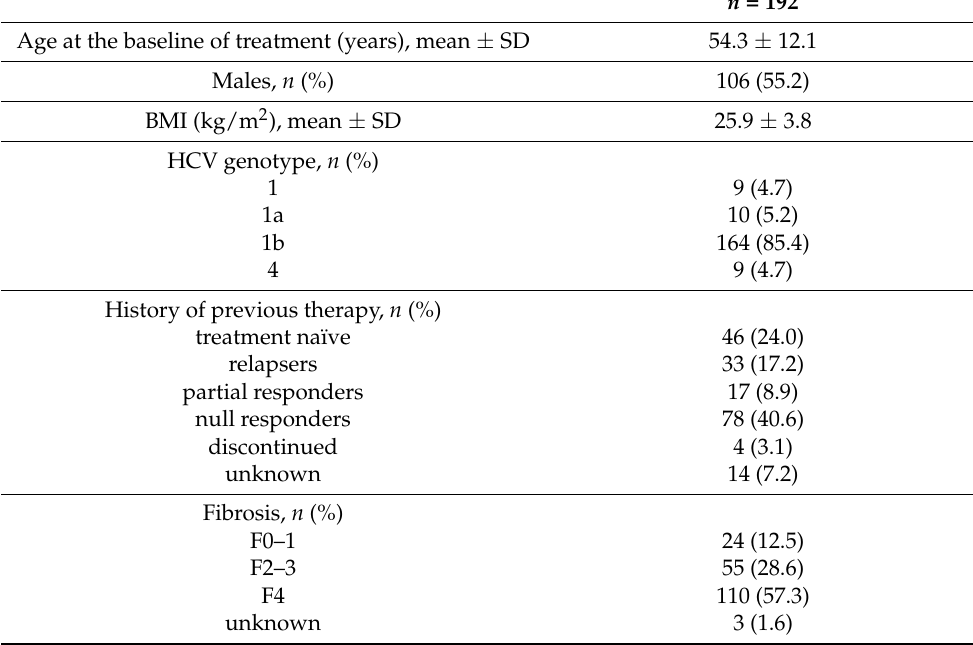
Table 1. Baseline characteristics of patients available for evaluation after 5 years following end of